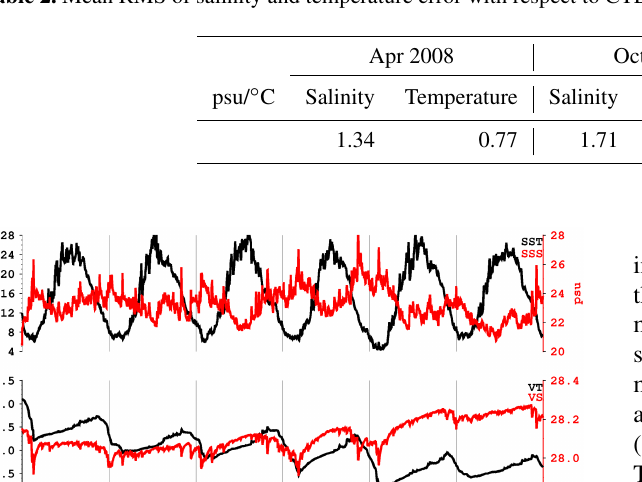
Figure 6. Annual mean of (a) salinity and (b) temperature for 2013 along the thalweg. Table 2. Mean RMS of salinity and temperature error with respect to CTD measurements in April and October 2008 and June 2013.